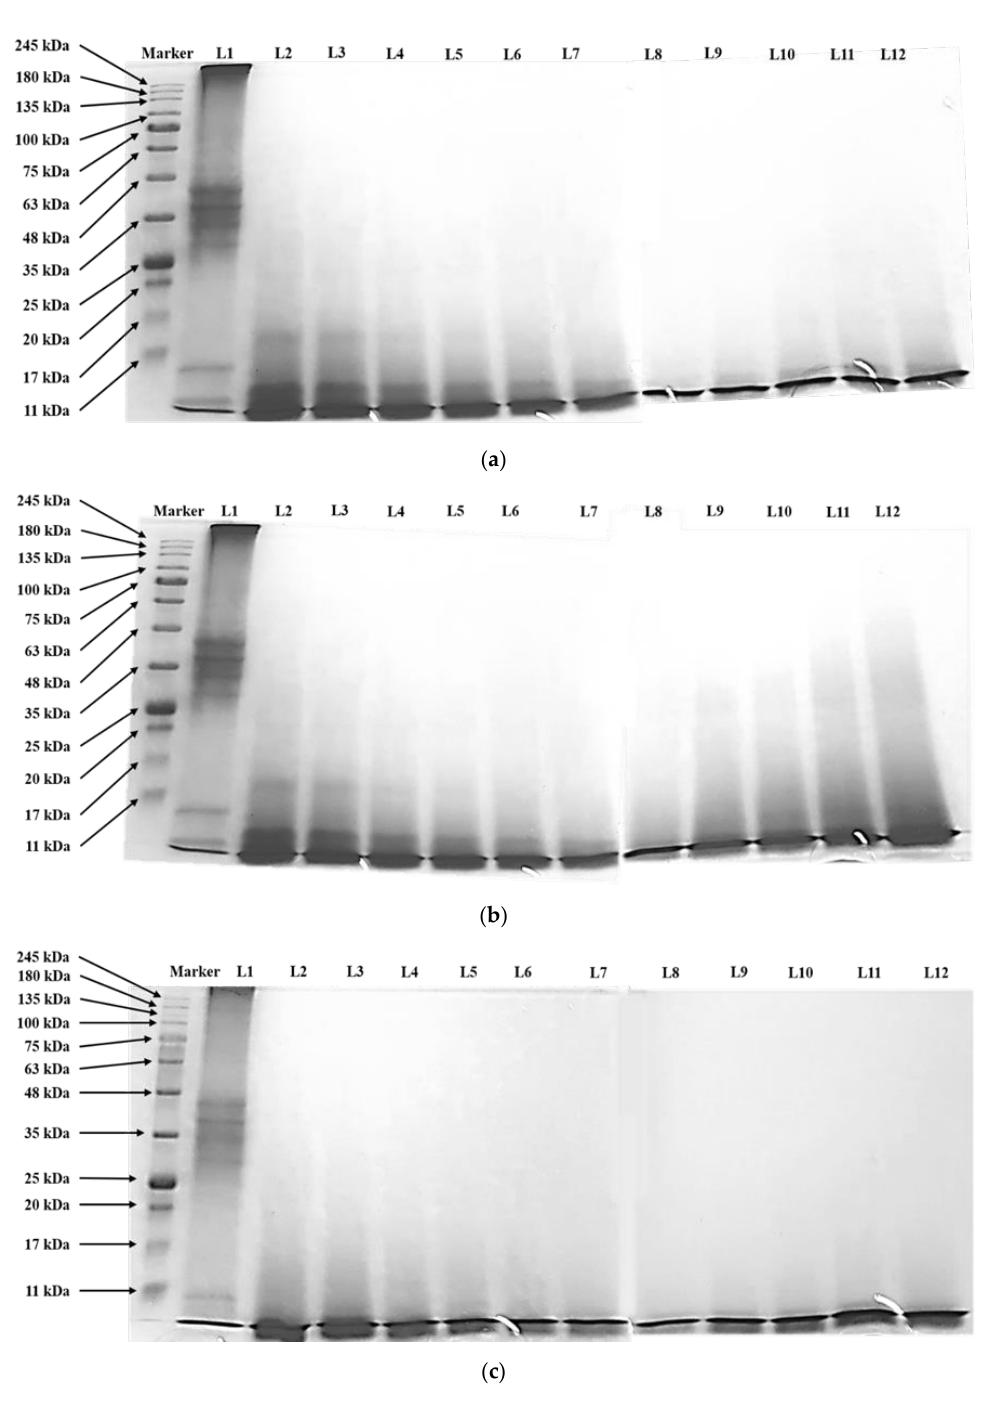
Figure 1. SDS-PAGE protein band profiling of albumin hydrolysate by ( a ) 100% trypsin, T; and ( b ) 100% chymotrypsin, C and ( c ) 50% trypsin + 50% chymotrypsin, T + C treatments at various substrate-to-enzyme (S / E) ratios and hydrolysis times. L1, control; L2, t = 0.5 h; L3, t = 1 h; L4, t = 2 h; L5, t = 3 h; L6, t = 4 h; L7, t = 5 h; L8, S / E = 10 ( w / w ); L9, S / E = 20 ( w / w ); L10, S / E = 30 ( w / w ); L11, S / E = 40 ( w / w ); L12, S / E = 50 ( w / w